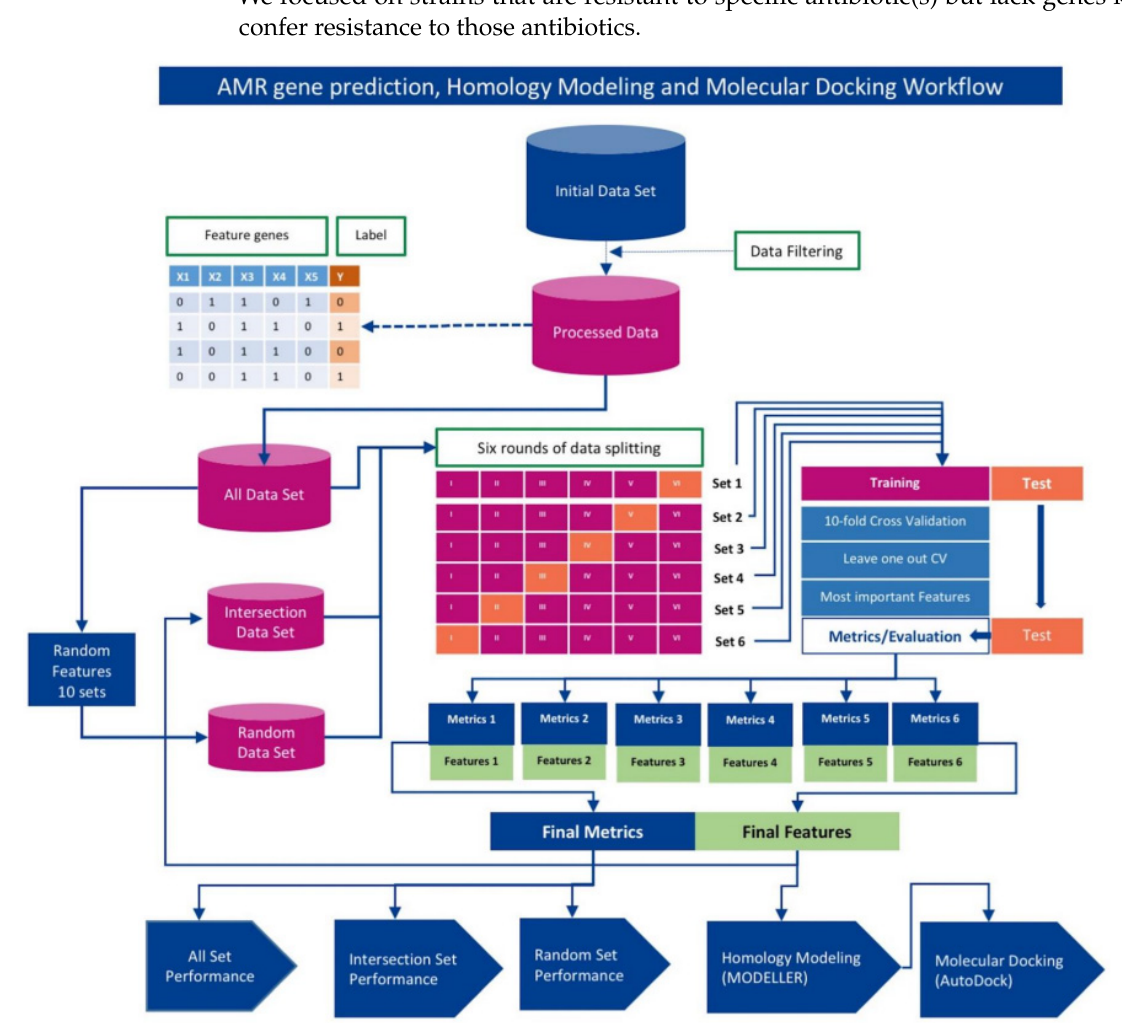
Figure 1. Schematic diagram of AMR trait and gene prediction pipeline that integrates machine learning, homology modeling, and molecular docking. The input data matrix contained gene presence/absence information (X i for ith gene; 1 denotes presence and 0 denotes absence) and phenotype information (Y; 1 denotes resistant and 0 denotes susceptible) for each strain (each row in the matrix). Assessment of machine learning (ML) algorithms was conducted using (i) All Set: entire gene dataset, (ii) Intersection Set: genes deemed important for discrimination and appeared consistently in all 6 rounds of cross-validation, and (iii) Random Set: randomly sampled genes (same number of genes as in Intersection set). Six-fold cross-validation was performed yielding performance of machine learning algorithms on respective data sets (i–iii). The Intersection Set genes were found to be yielding overall optimal performance and were therefore subjected to homology stable conformations with corresponding ligands (antibiotics) in molecular